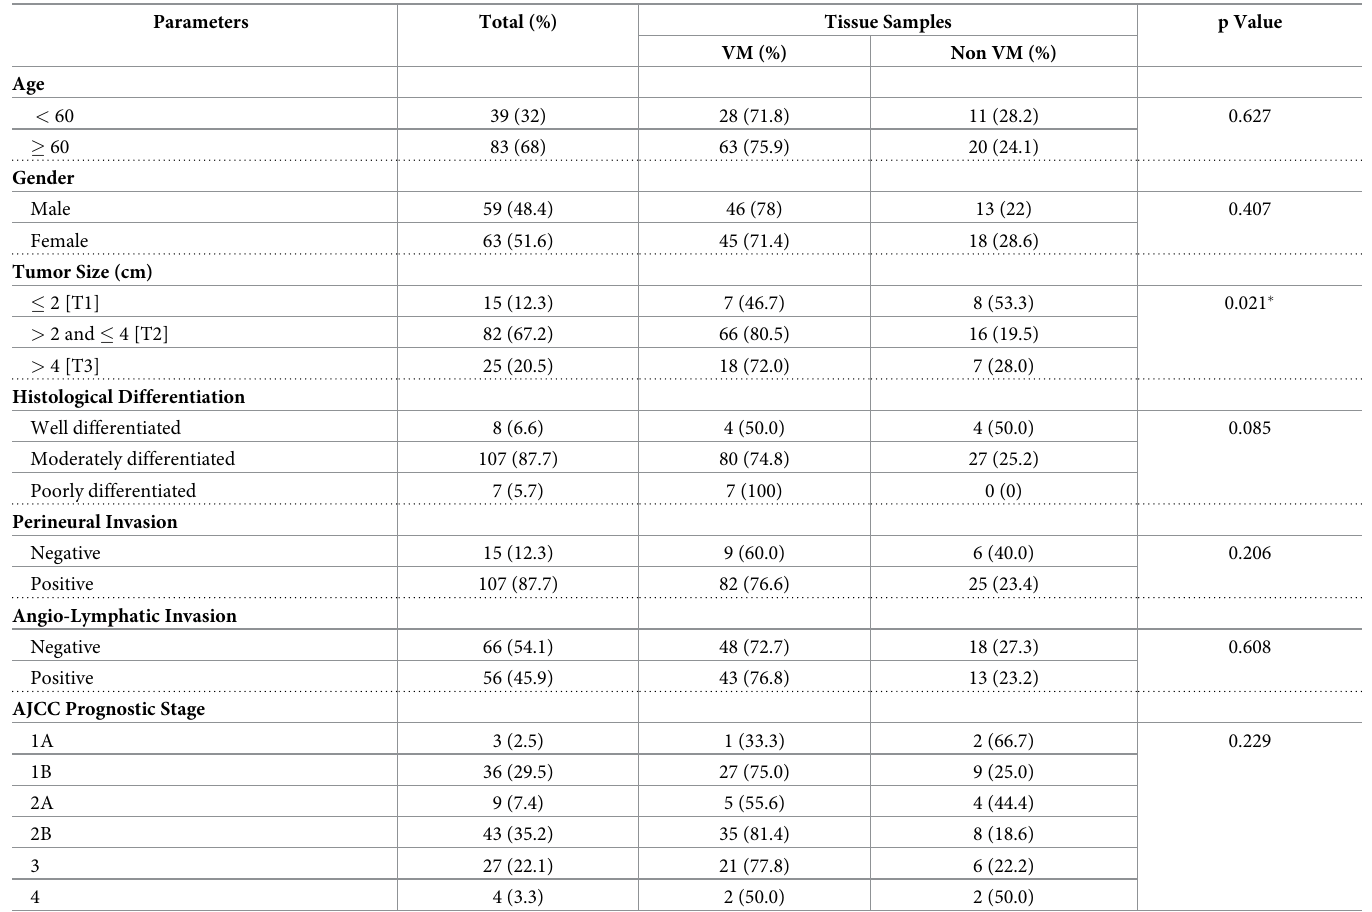
Table 1. Association of VM and PDAC